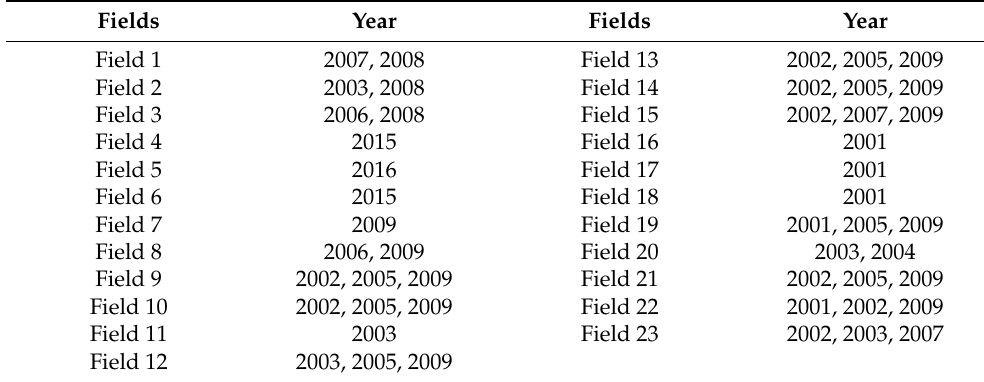
Table 1. Yield maps involved in the study.